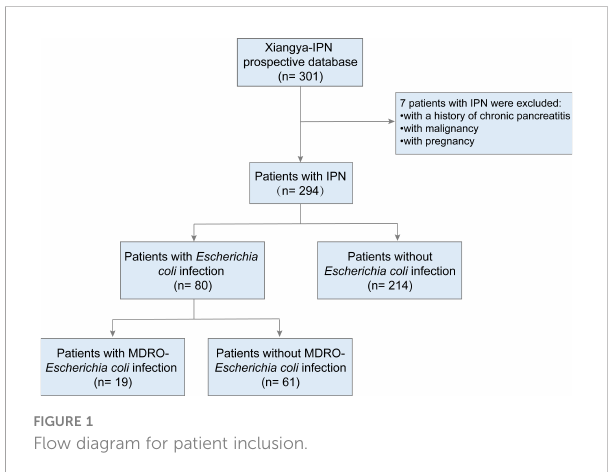
FIGURE 1 Flow diagram for patient